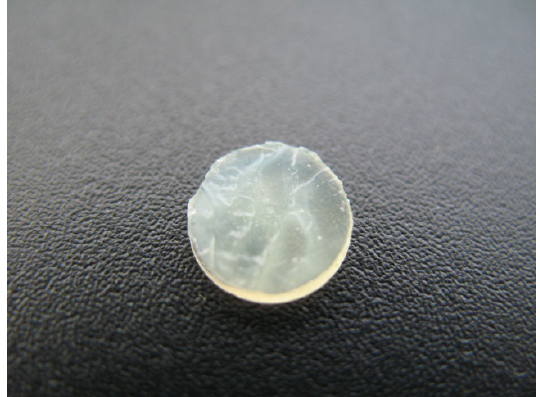
Figure 2. Ciprofloxacin precipitate film on the surfaces of pHEMA TRIS + HA 132 kDa disc.